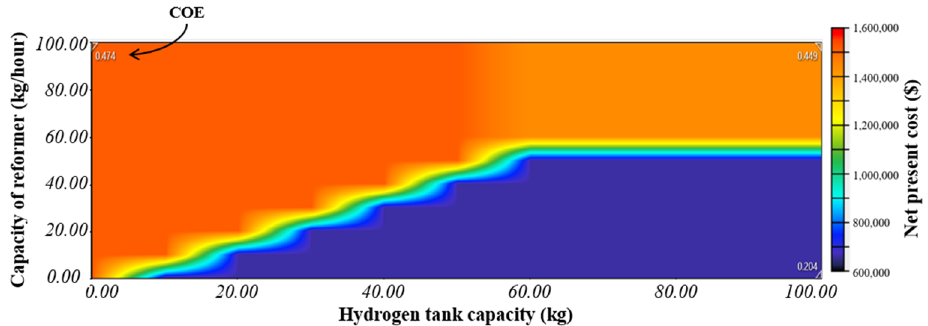
Figure 21. Sensitivity analysis for reformer and hydrogen tank capacity with variation in NPC.